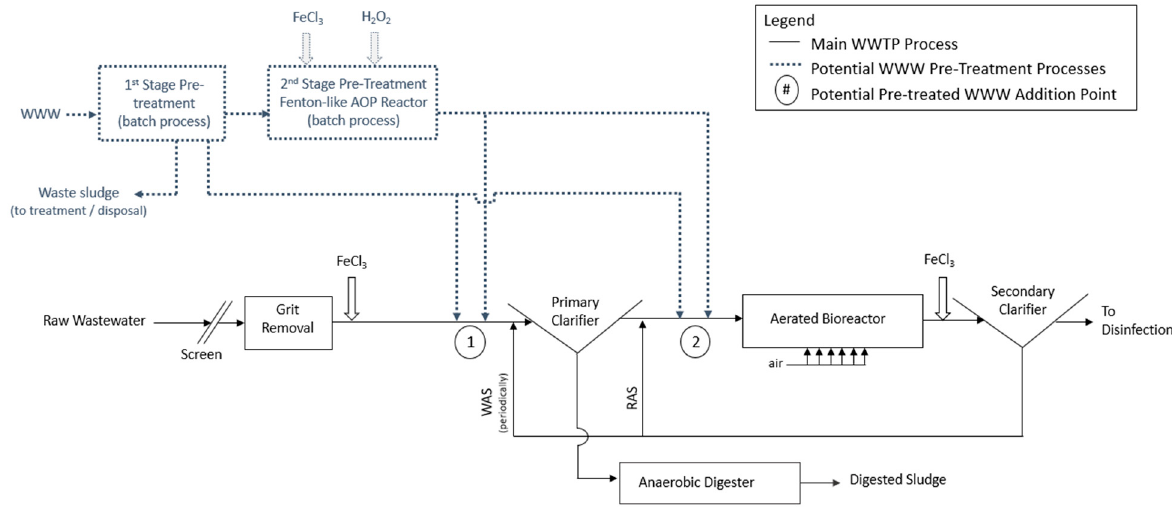
Figure 1. Process flow diagram illustrating potential incorporation of Fenton-like pre-treatment of WWW at a municipal WWTP.